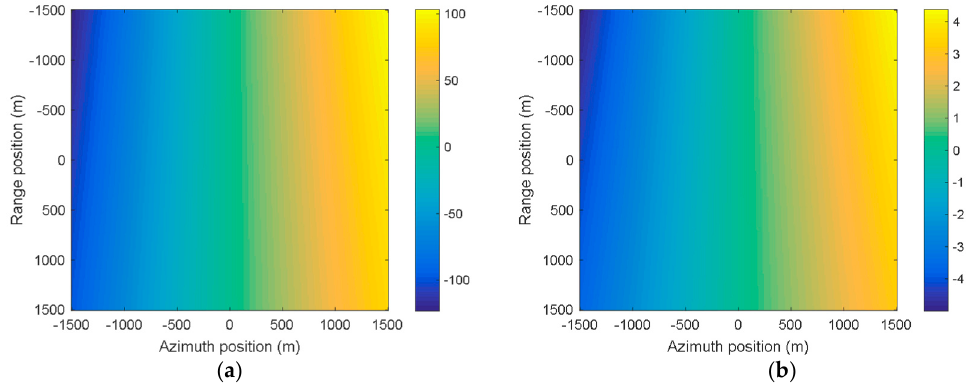
Figure 6. The spatial variance of the Doppler parameters. ( a ) The Doppler rate; ( b ) the derivative of the Doppler rate.